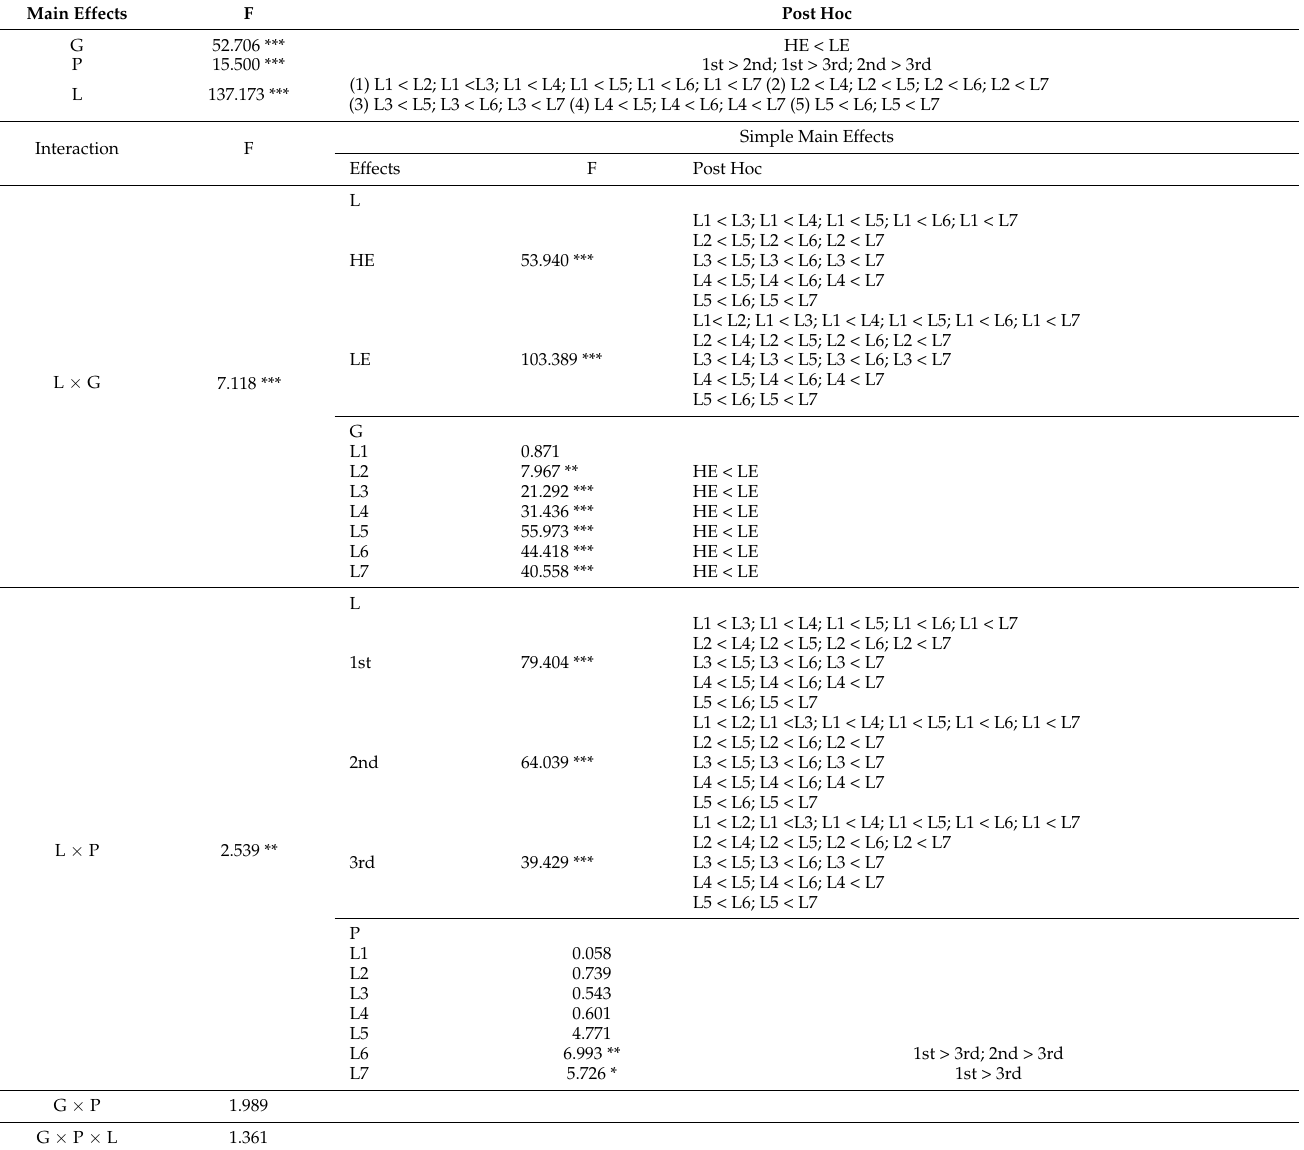
Table 2. Results of mixed three-way